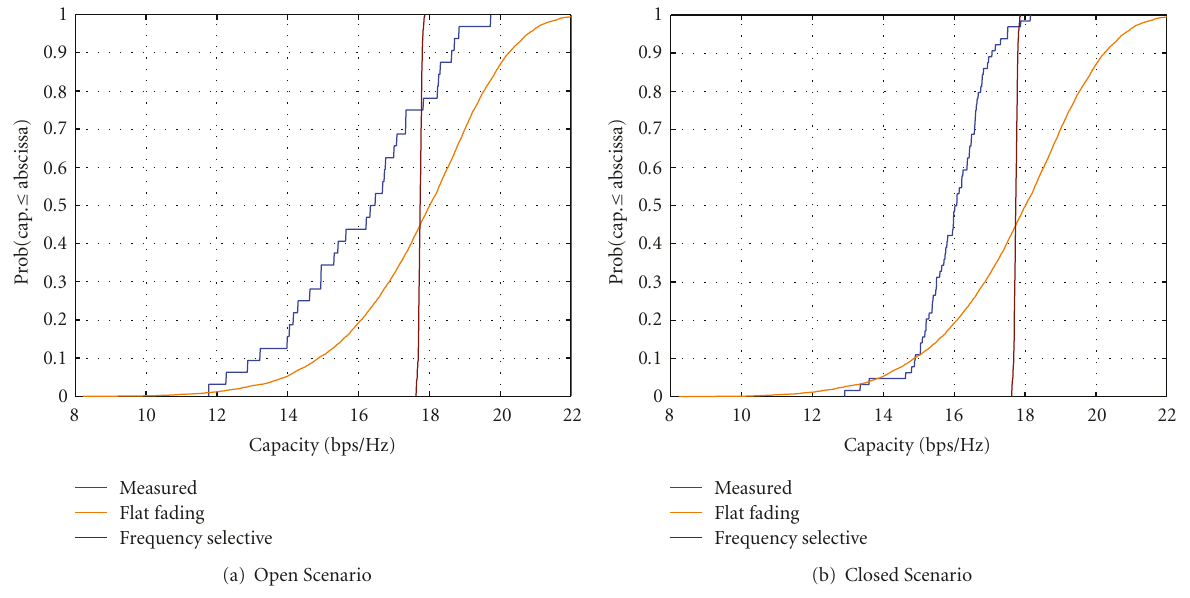
Figure 10: The MIMO channel capacity with SNR = 30 dB measured and modeled in HNLOS areas.